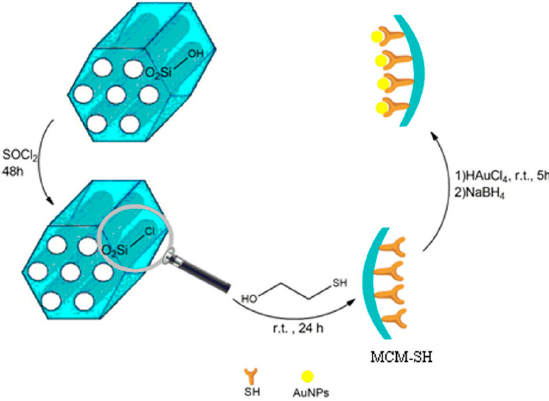
Figure 47. Schematic description for preparation of Au@HS-MCM nanocomposite. Reproduced with permission from [91]. Copyright 2015 Elsevier B.V.